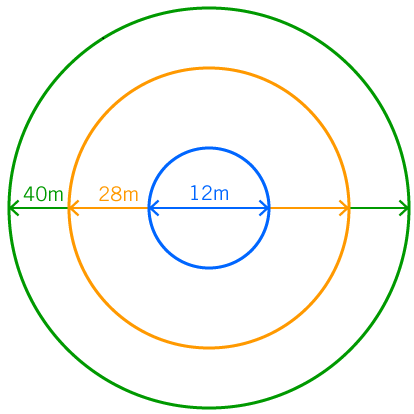
Figure 3. Circular nested plot design consisting of three circular plots with diameters of 12, 28, and 40 m. Within the 12-m diameter plot, all trees with a DBH of ≥ 5 cm were measured; within the circular ring between 12 and 28 m diameter plots, all trees with a DBH ≥ 25 cm were measured; and in the outer ring, between 28 and 40 m diameter plots, all trees with a DBH ≥ 50 cm were